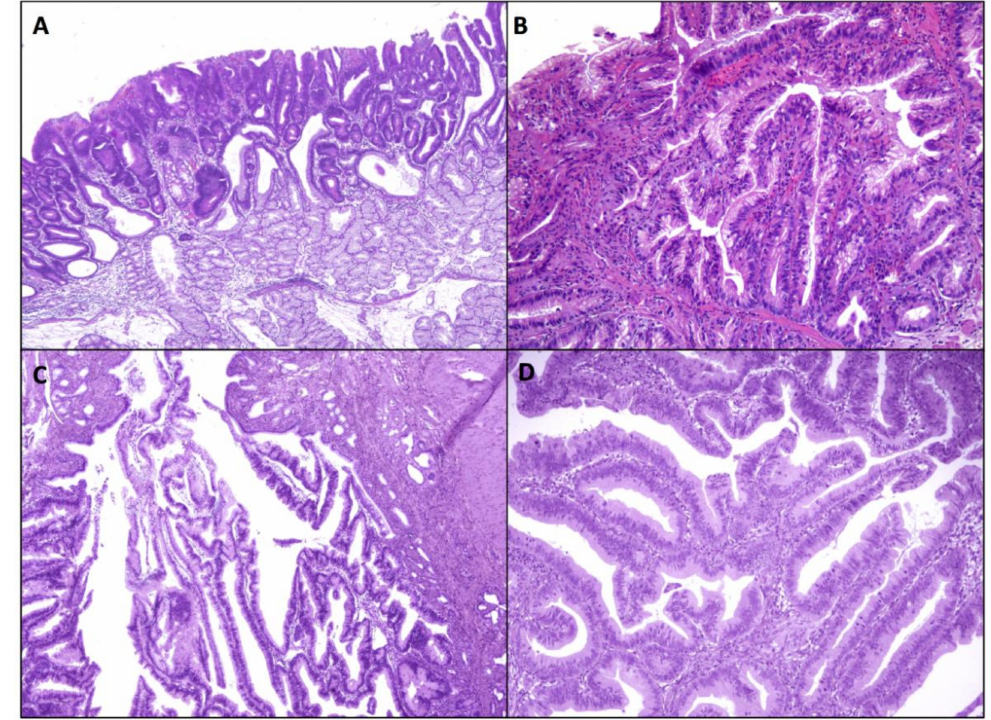
Figure 2. Non-ampullary and ampullary sporadic, glandular precursor lesions. ( A ) Sporadic non- ampullary, low-grade, intestinal-type adenoma. ( B ) Sporadic non-ampullary, low-grade foveolar-type adenoma. ( C , D ) Sporadic non-invasive intra-ampullary papillary-tubular neoplasm, with admixed low grade ( C ) and high grade ( D ) dysplastic foci. Patients signed informed consent regarding publishing their data before having their endoscopic/surgical